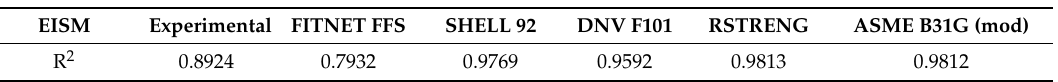
Table 3. Summary of the coefficient of determination (R 2 ) of X46 and X52 grade pipe burst pressure as compared with the experimental and industry standard models (EISM).